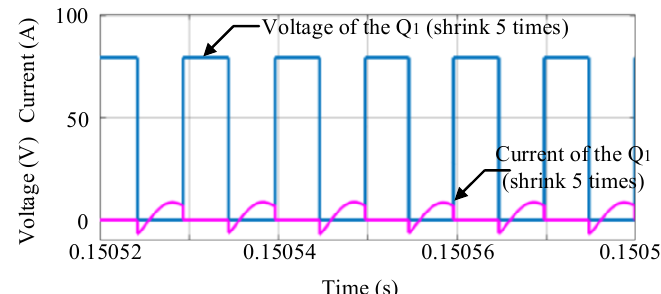
Figure 19. Voltage and current of Q 1 .